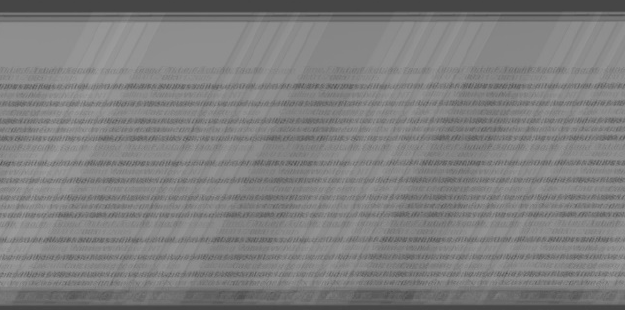
Figure 5. The reconstructed image (rasterized) in incorrect way, VGA interface signal as a source of reveal emission, 640 × 480/60 Hz mode, 62.5 MHz sampling rate, line length 1985, summed 10 times.